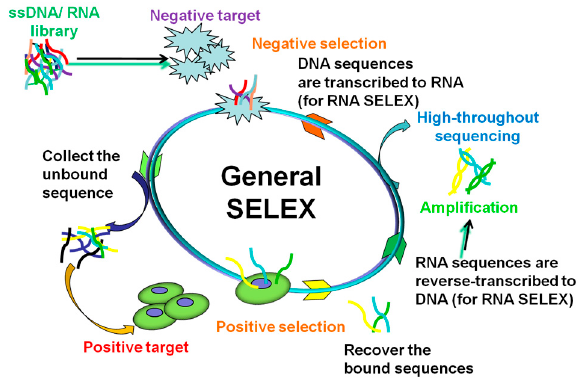
Figure 1. General SELEX procedures.